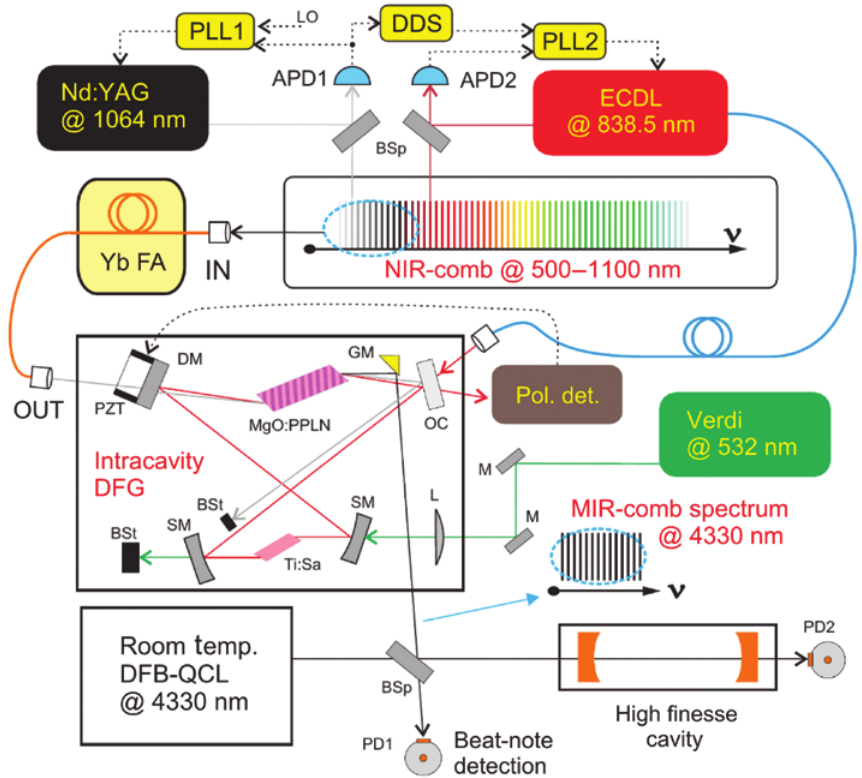
Figure 11: Mid-IR OFC generation